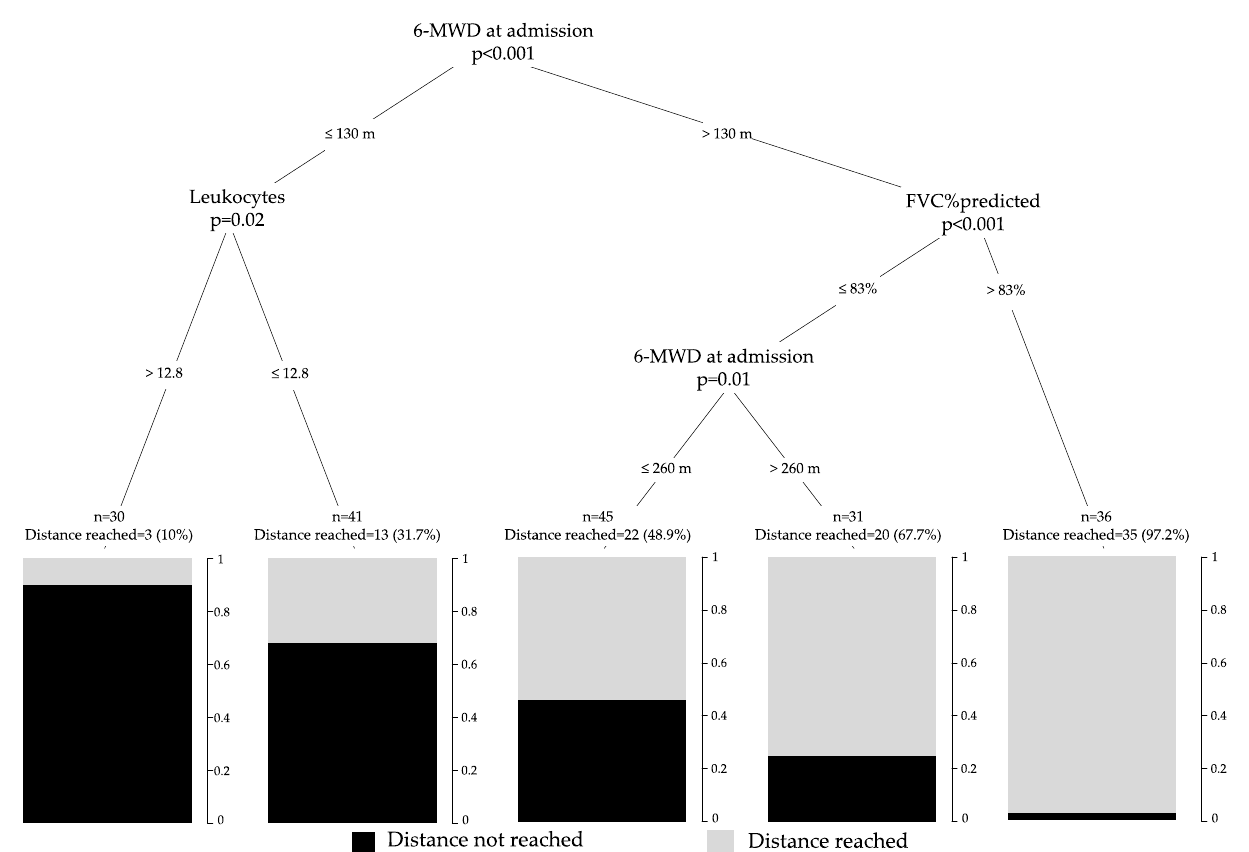
Figure 2. Separation of non-responders into different groups according to influencing variables (tree model). Notes: 6MWD, six-minute walking distance; FVC, forced vital capacity.